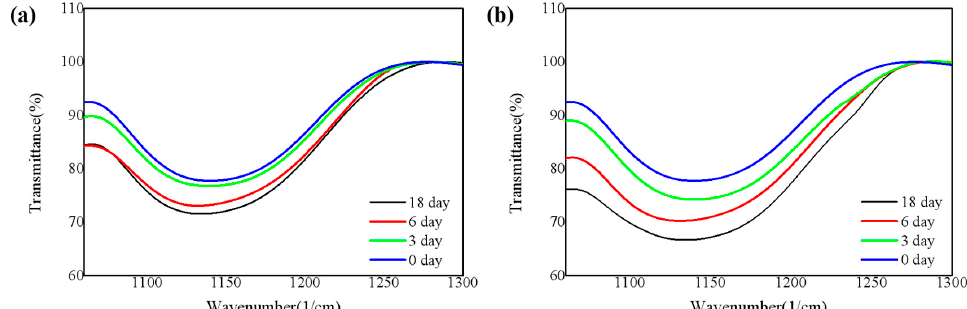
Figure 3. Infrared absorbance in the Si-O bond for four SiN x films ( a ) in the air and ( b ) under 85 °C/85% RH. Figures 4 and 5 show the absorption peaks corresponding to Si-H bonds and N-H bonds respectively [23]. As shown in Figures 4 and 5, the deposited films contain both Si- H bonds and N-H bonds. The overall trend is that both Si-H bonds and N-H bonds de- crease with time. In the case of higher humidity, the oxidation is more intense, and the H bonds are more likely to break to form Si-O bonds, so that the Si-H bonds and N-H bonds gradually decrease, and the Si-O bonds increase.